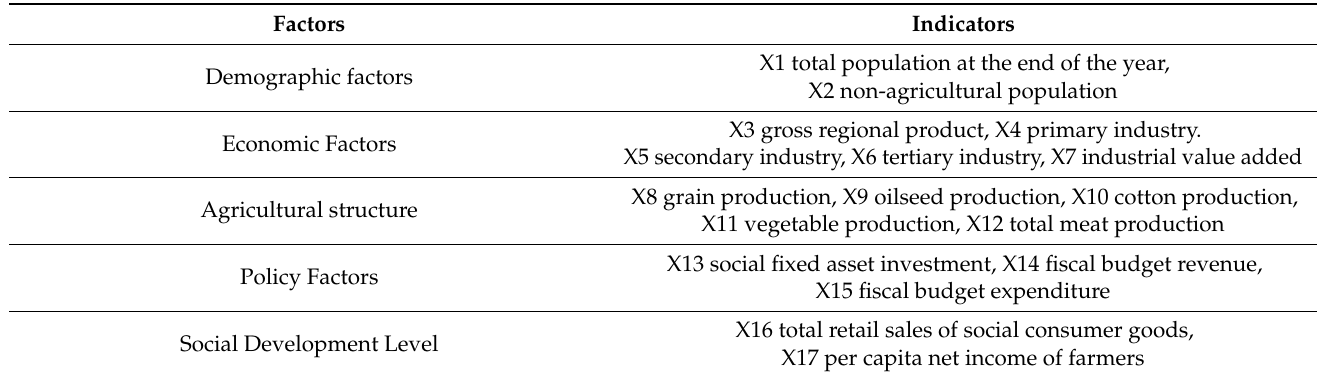
Table 8. Change index of land use driving force.